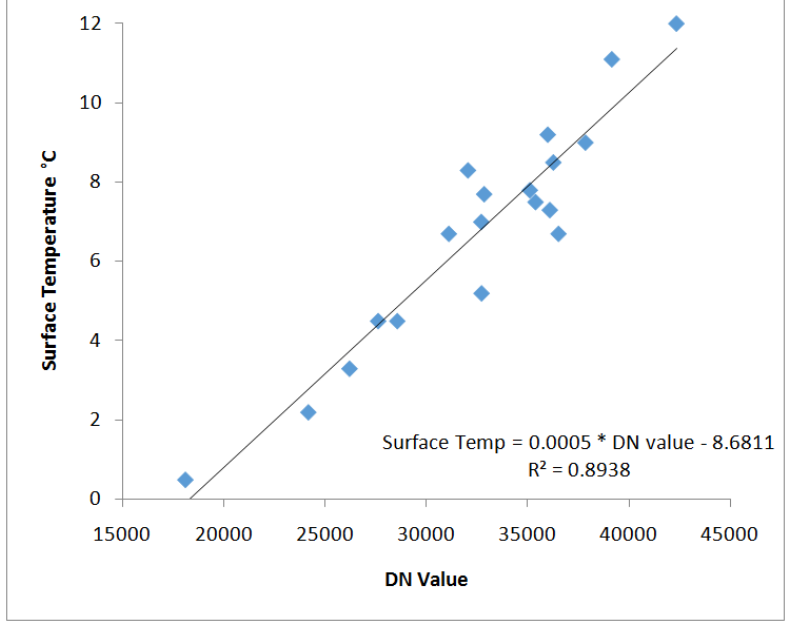
Figure 7. Statistical relationship between thermal infrared DN values from UAV imagery and ground measured surface temperature for 19 sample points at the Robinson Ridge test